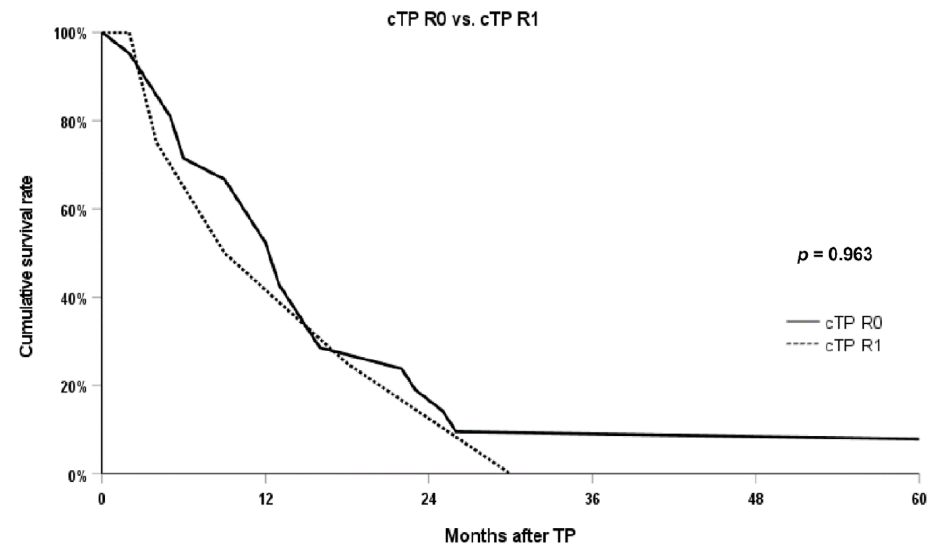
Figure 2. Comparison of overall survival between R0 cases and R1 cases after cTP. Abbreviations: cTP, completion total pancreatectomy. Table 4. Comparison of postoperative outcomes between cTP R0 group and PD R0 group extracted by PSM (number (percent) and mean ± standard